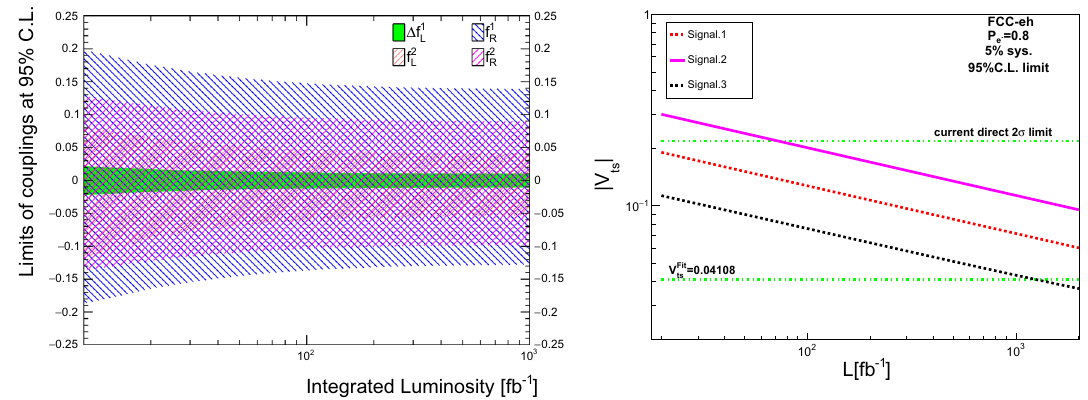
Fig. 6.9 Expected sensitivities as a function of the integrated luminosity on the SM and anomalous Wtb couplings [180] (left; the constraint on (cid:4) f L for f L is shown, and on | V ts | [184] 1 1